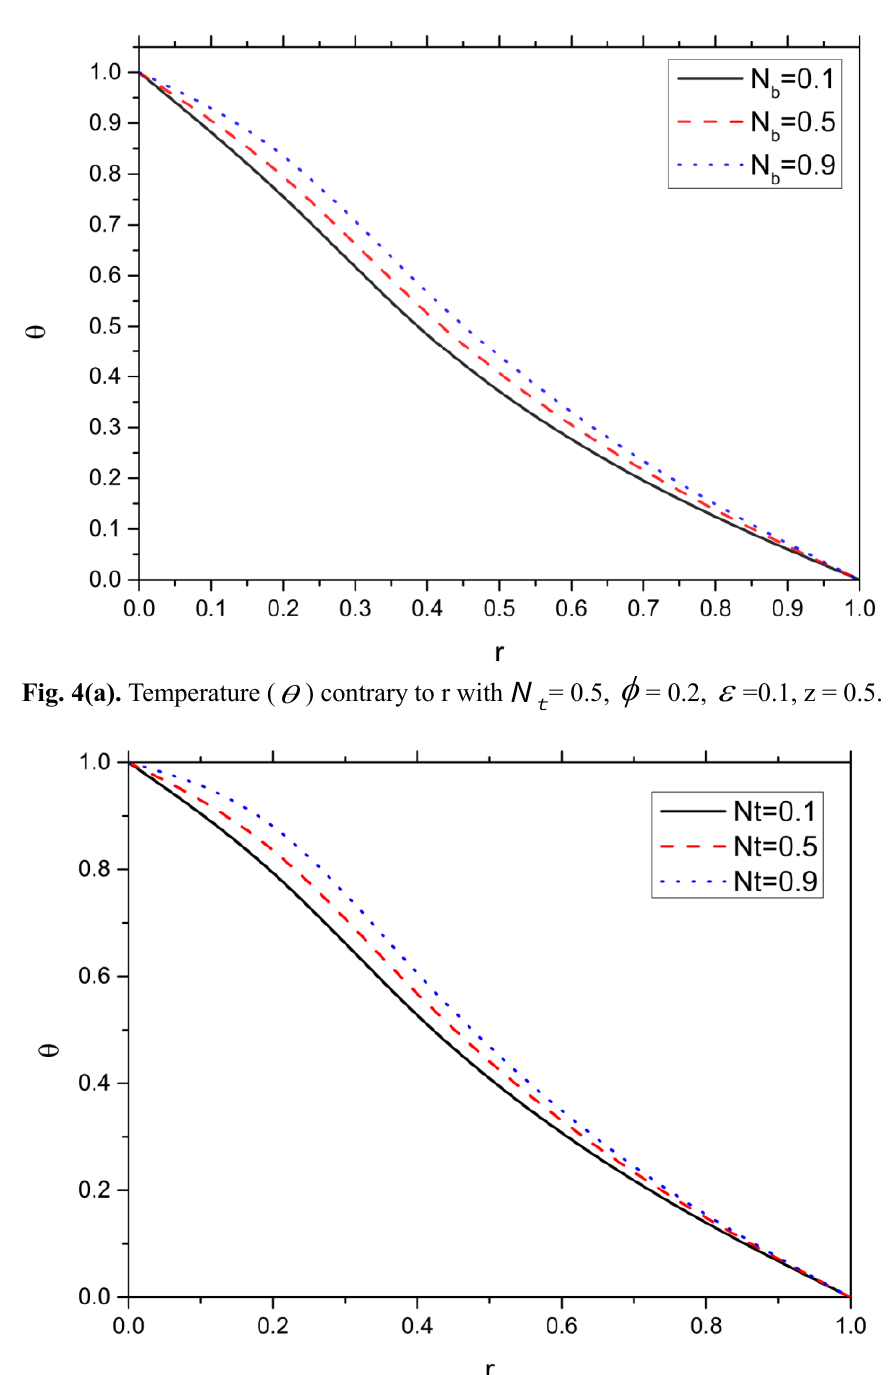
Fig. 4(b). Temperature (  ) contrary to r with